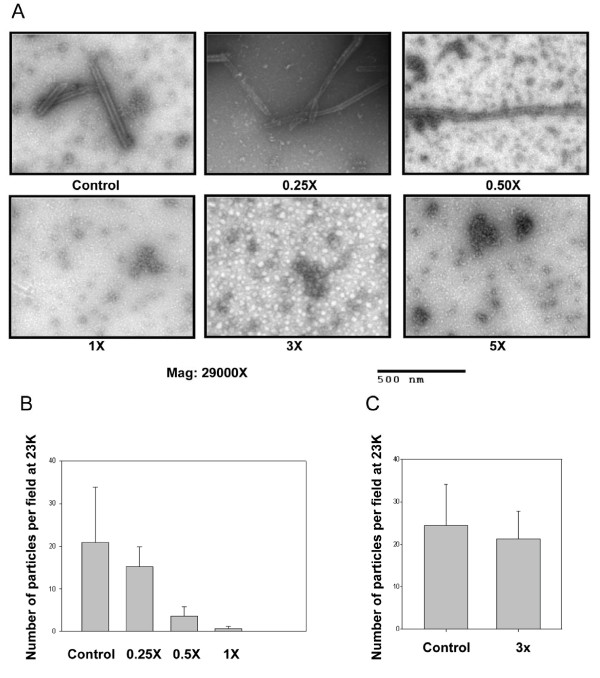
Inhibition of in vitro assembly by NYAD-201. (A) Negatively stained EM images of mature-like particles resulting from in vitro assembly of CA proteins in the presence of no peptide (Control), 0.25-, 0.5-, 1.0-, 3.0- and 5-fold molar equivalent of NYAD-201. (B) A dose-response effect of NYAD-201 on the tube-like mature particle formation. (C) In vitro assembly of CA proteins in the presence of no peptide (control) and 3-fold molar equivalent of NYAD-233.